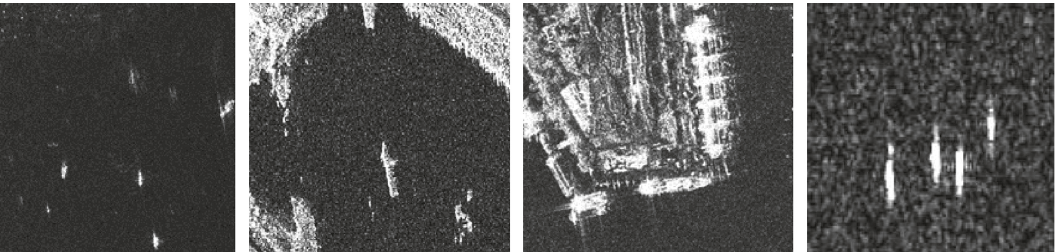
Figure 5: A few images in our ship detection dataset.